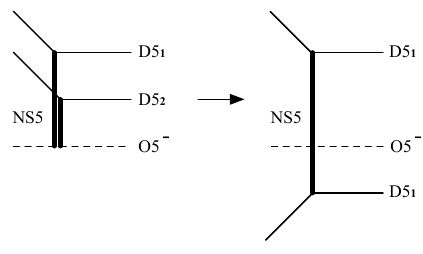
Figure 8 . 5-brane web with an O 5 -plane, which is obtained by the combination of S- dualities and T-dualities.